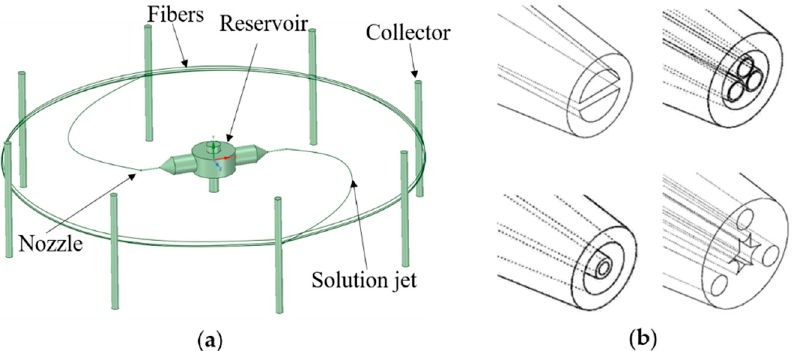
Figure 6. ( a ) Schematic of the centrifugal spinning process; ( b ) various cross-section shapes of nozzles for diverse morphologies of nanofibers in centrifugal spinning [106] (Copyright 2015, China Intellectual Property Office).